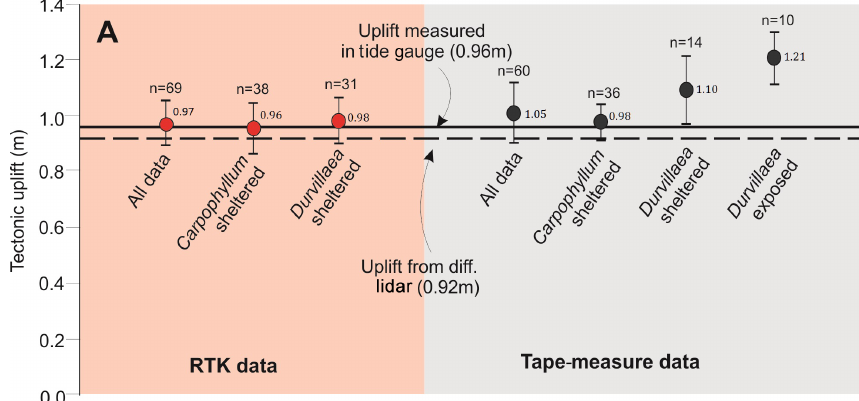
Figure 5. Uplift at the Kaik¯oura tide gauge calculated from the upper living positions of various kelp holdfasts and exposure sites plotted against the offset recorded at the same locality using the tide gauge and differential lidar. Holdfast data are presented as the mean and standard deviation, while the tide-gauge and lidar data are presented as the mean only. Black numbers beside the data points indicate the mean values, while n values at the top represent the number of measurements per category.